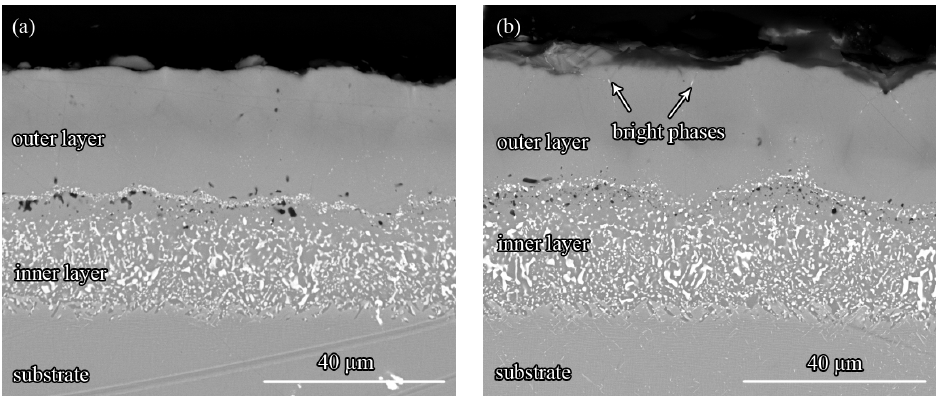
Figure 6. The cross ‐ sectional morphologies of the coatings after aluminization: ( a ) PtAl; ( b ) PtZrAl. Figure 6. The cross-sectional morphologies of the coatings after aluminization: ( a ) PtAl; ( b ) As for the PtZrAl coating, the cross ‐ sectional morphology is nearly similar to the PtAl coating, but some bright phases could be distinctly observed in the outer layer. The average compositions of the PtZrAl coatings in the outer layer are 48.3Al ‐ 1.6Cr ‐ 3.8Co ‐ 41.9Ni ‐ 3.9Pt ‐ 0.5Zr (at.%), detected by